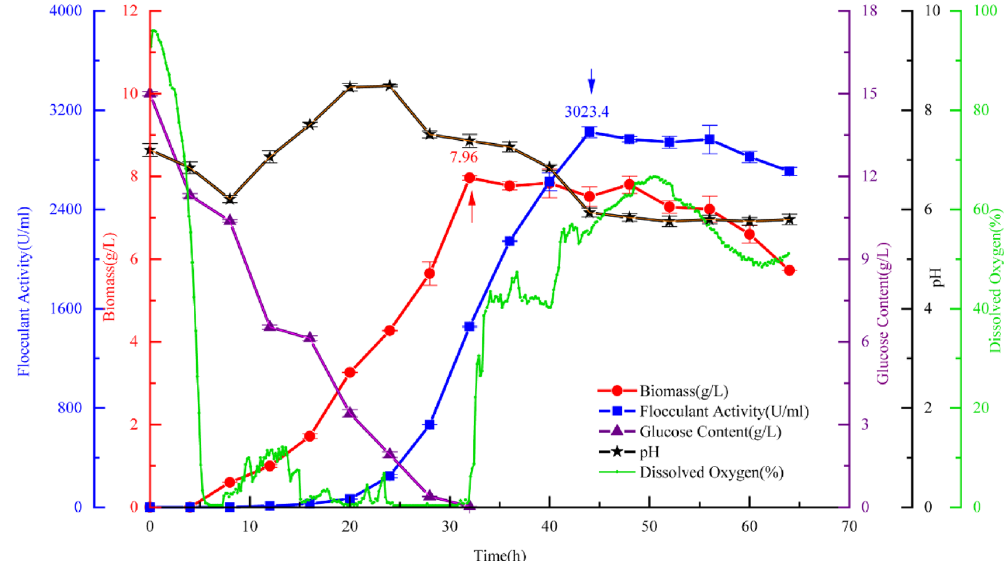
Fig. 2 Fermentation of P. fluorescens mutant T4-2 in a 3.6-L bioreactor in an optimized medium